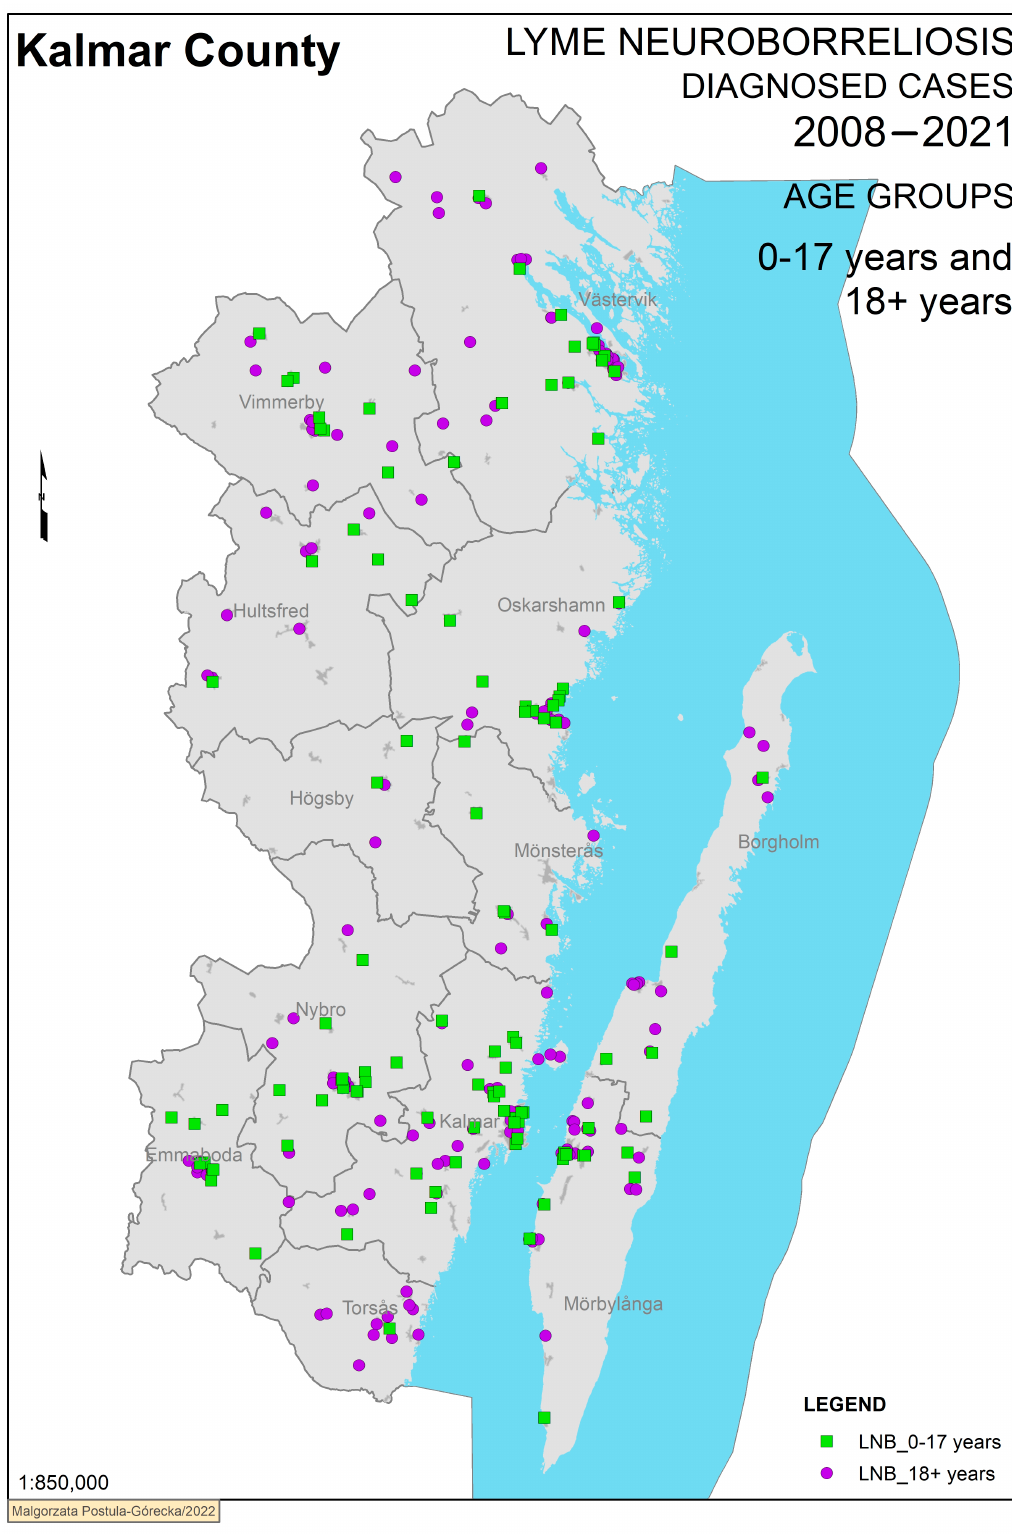
Figure 4. Definite cases of Lyme neuroborreliosis grouped by children and adults. Figure 4. Definite Lyme neuroborreliosis cases in Kalmar County 2008–2021 grouped by children (0–17 years) and adults (18+ years). The municipalities within Kalmar County are shown in